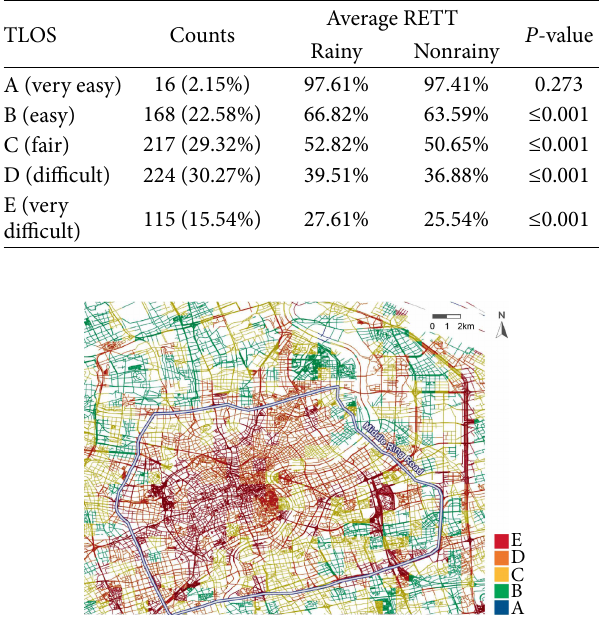
Table 2: Outcomes of TLOS clustering.